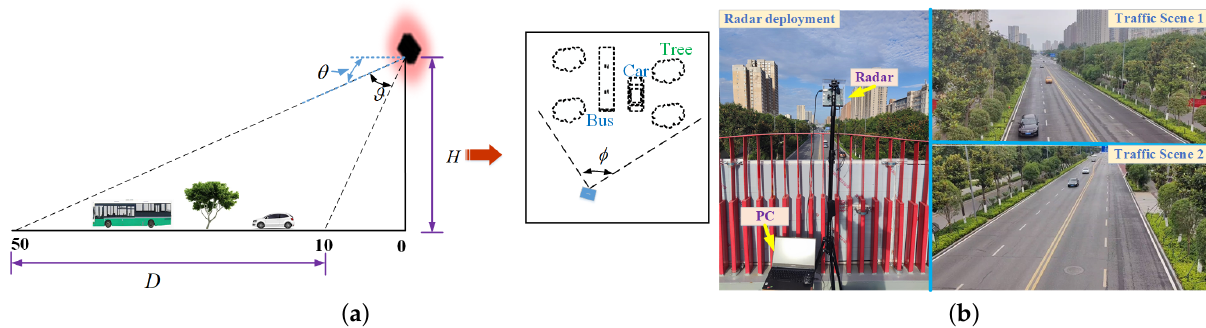
Figure 3. ( a ) Traffic scene model. ( b ) Radar deployment and test scenarios.